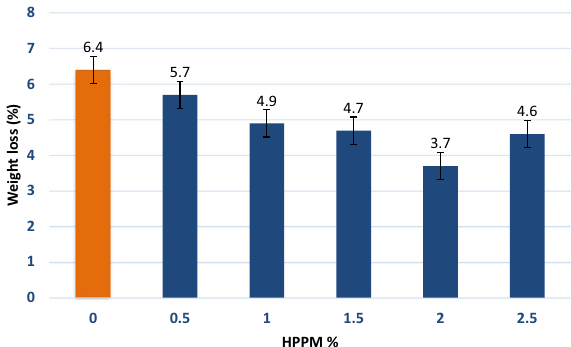
Figure 11. Abrasion resistance enhancement 28 days after adding the